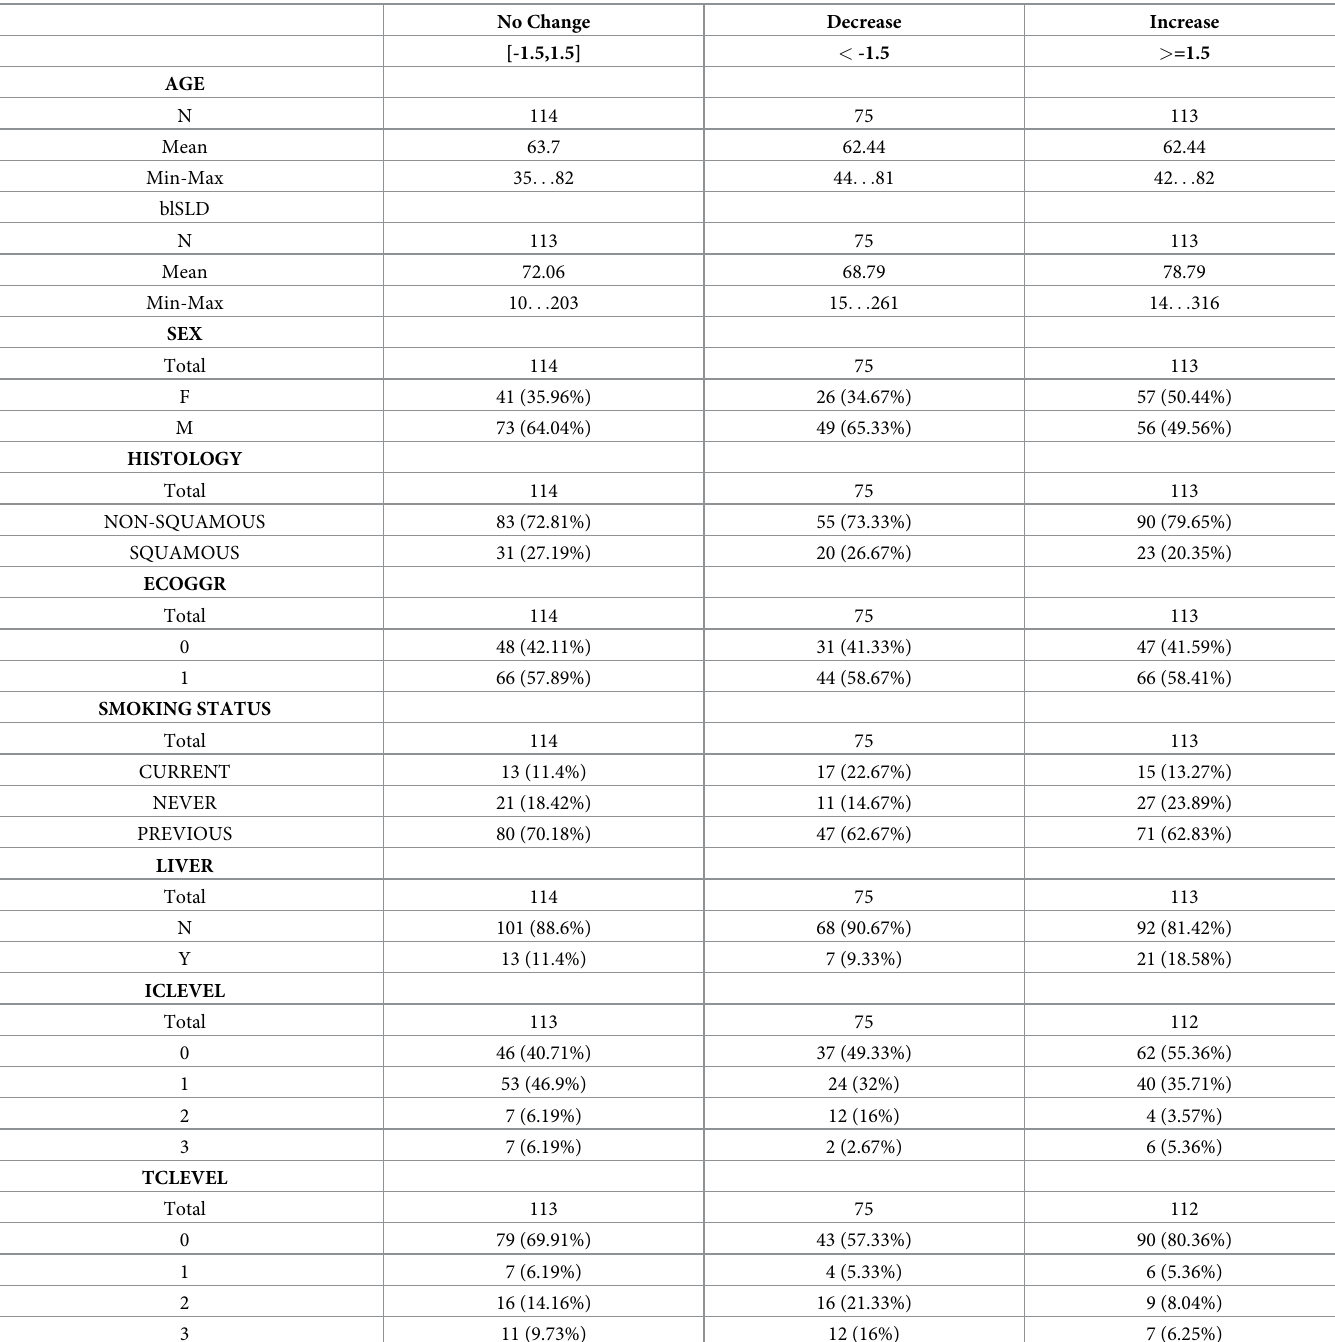
Table 2. Patient demographics and clinical characteristics in the three CRP fold change buckets for atezolizumab in